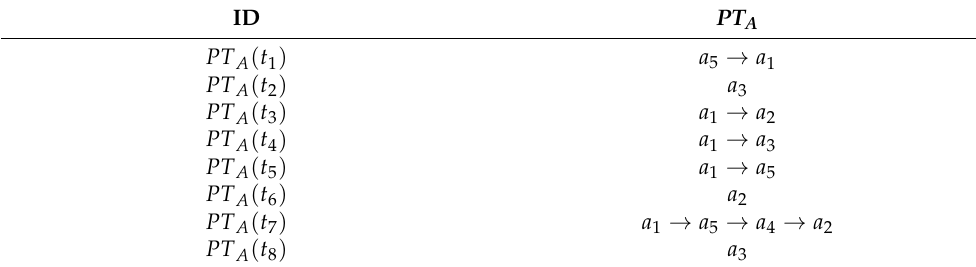
Table 2. Trajectory projection set T A of T